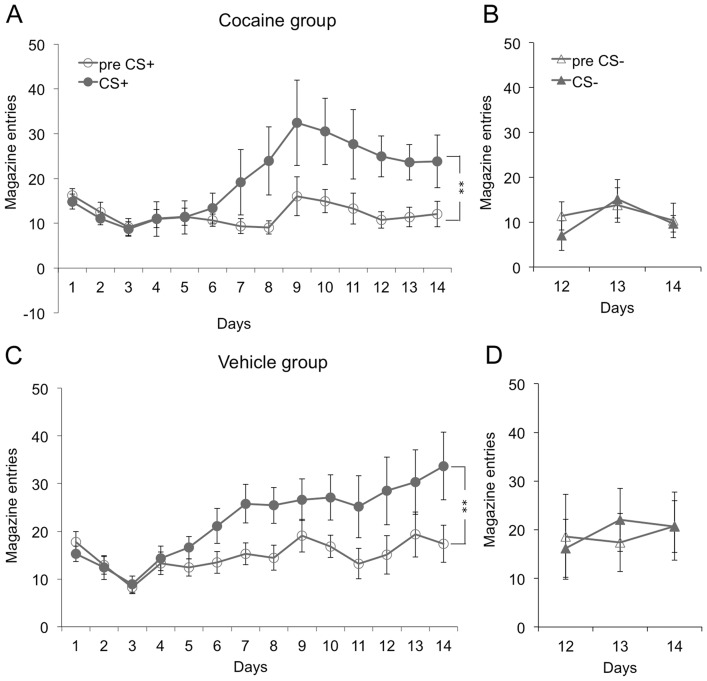
Pavlovian training.Pavlovian training, shown as magazine entries made in response to the CS and in the 30 s period immediately before it (preCS), displayed separately for CS identity and group. CS+ trials for the cocaine group (2A) and the vehicle group (2C) are shown next to CS− trials for the cocaine group (2B) and vehicle group (2D). Means +/− SEM. ** = p<0.01.